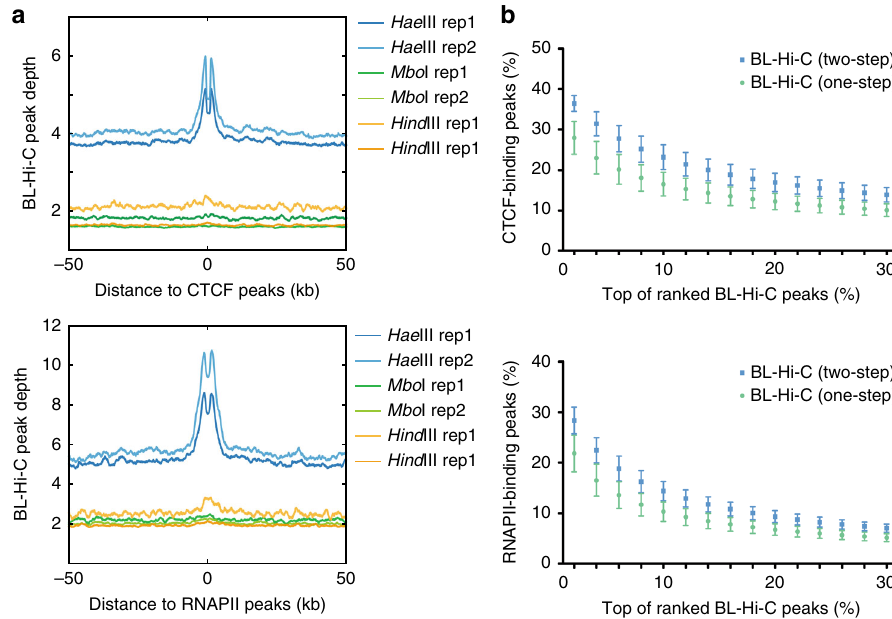
Fig. 4 Validation of enzyme digestion and proximity ligation. a The enzymes Hae III, Mbo I, and Hind III are applied for BL-Hi-C library construction with the same two-step ligation protocol. The distances from BL-Hi-C peaks to CTCF or RNAPII ChIP-seq peaks, measured from the centers, are investigated. The y -axis refers to the average BL-Hi-C peak depth, which is normalized by 1 M sequenced reads. b One-step (green) or two-step (blue) proximity ligation is applied to the construction of BL-Hi-C libraries with the same Hae III enzyme digestion. The x -axis shows the percentage of BL-Hi-C peaks ranked by q -value for each library. The y -axis shows the percentage of peaks that overlap with the public CTCF or RNAPII ChIP-seq